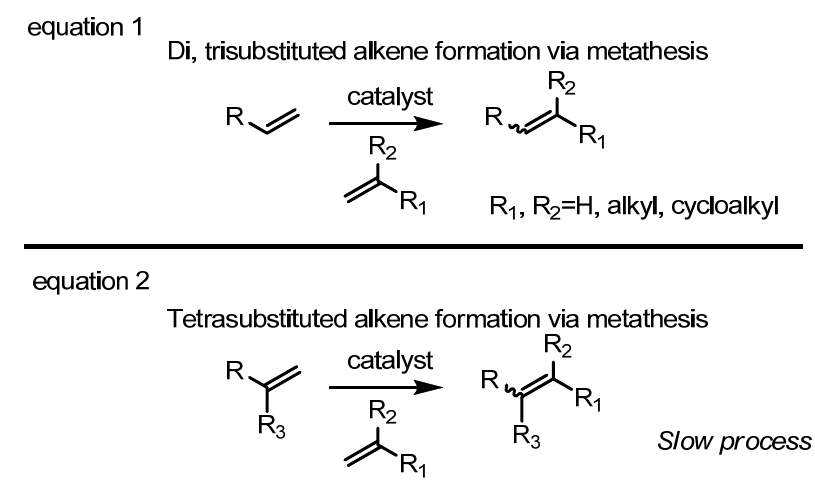
Figure 2. Difficulty in the generation of tetrasubstituted olefins via